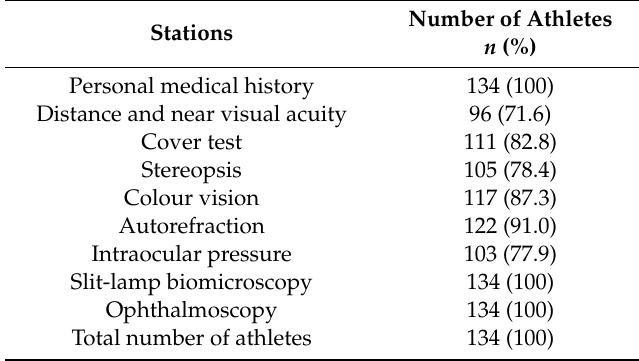
Table 1. Number of athletes completing the screening stations. The stations are presented according to the screening order.